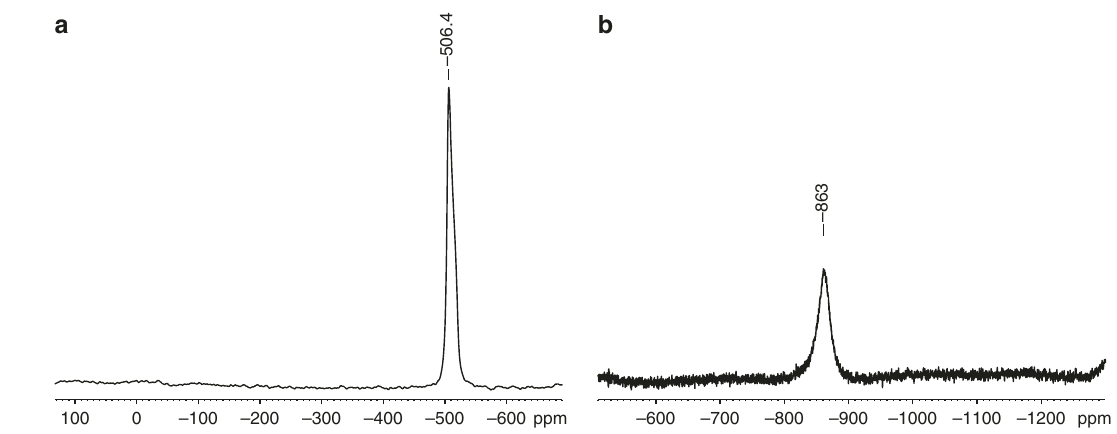
Fig. 1 NMR spectroscopy. a 31 P{ 1 H} MAS NMR spectrum of P 4 @ C . b 75 As NMR spectrum of As 4 in CS 2 extracted from As 4 @